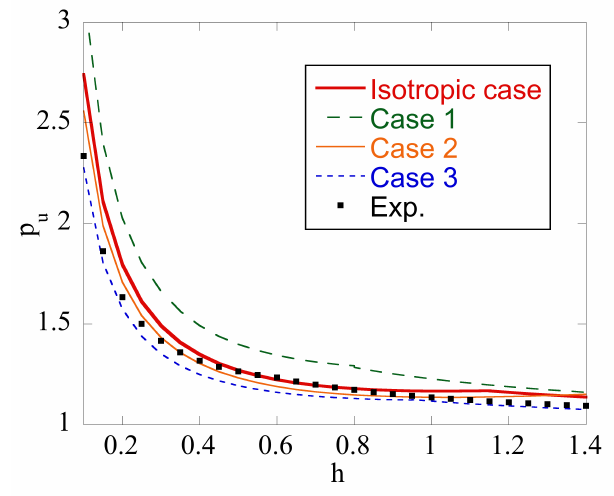
Figure 5. Effect of plastic anisotropy on the dimensionless limit load at m = 1.